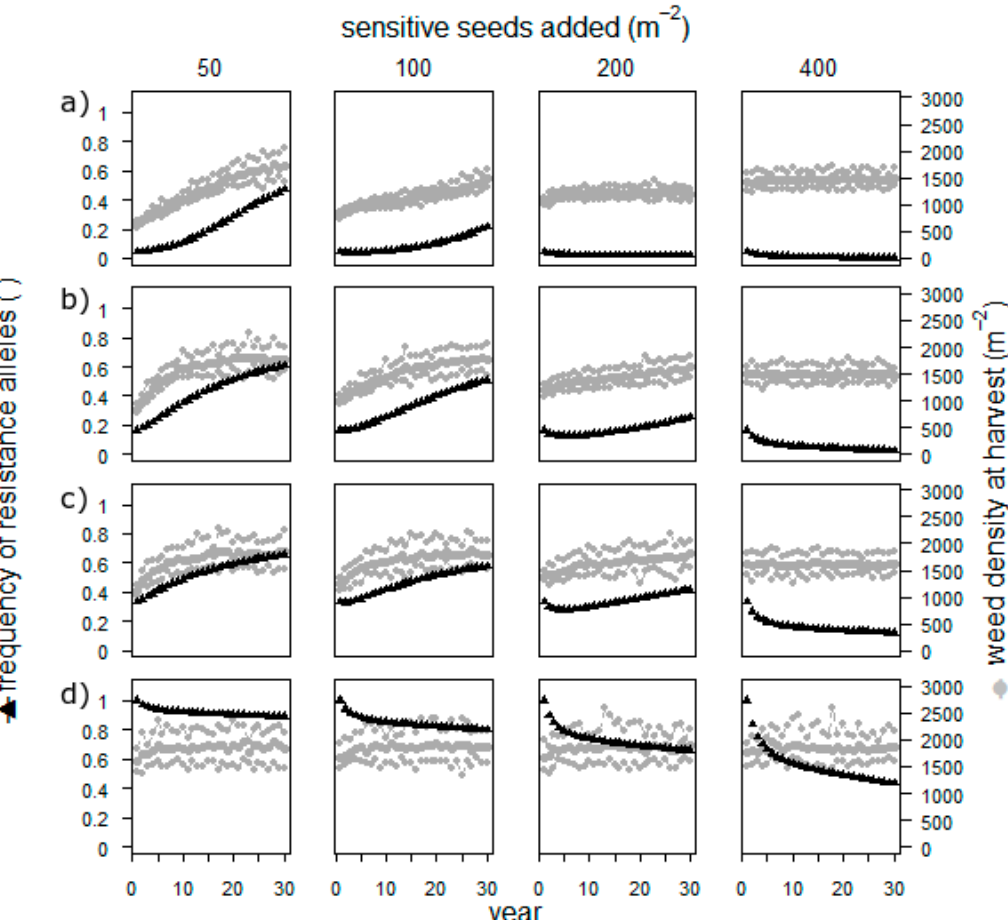
Figure 4. Results of a Galium aparine herbicide resistance model in winter wheat, simulated over 30 years [16]. The frequency of resistance alleles in the seed bank after harvest (means of 20 simulation runs) and weed density at harvest (means, maximum, and minimum of x simulation runs) depend on the resistance status of the population (i.e., the frequency of resistance alleles) at simulation start: (a)0.03, 0.08, and 0.02; (b) 0.2, 0.1, and 0.5; (c) 0.6, 0.4, and 0.8; and (d) 1 for all alleles. Sensitive seeds were added in densities of 50, 100, 200, and 400 seeds/m 2 yearly. Figure extracted from [16].